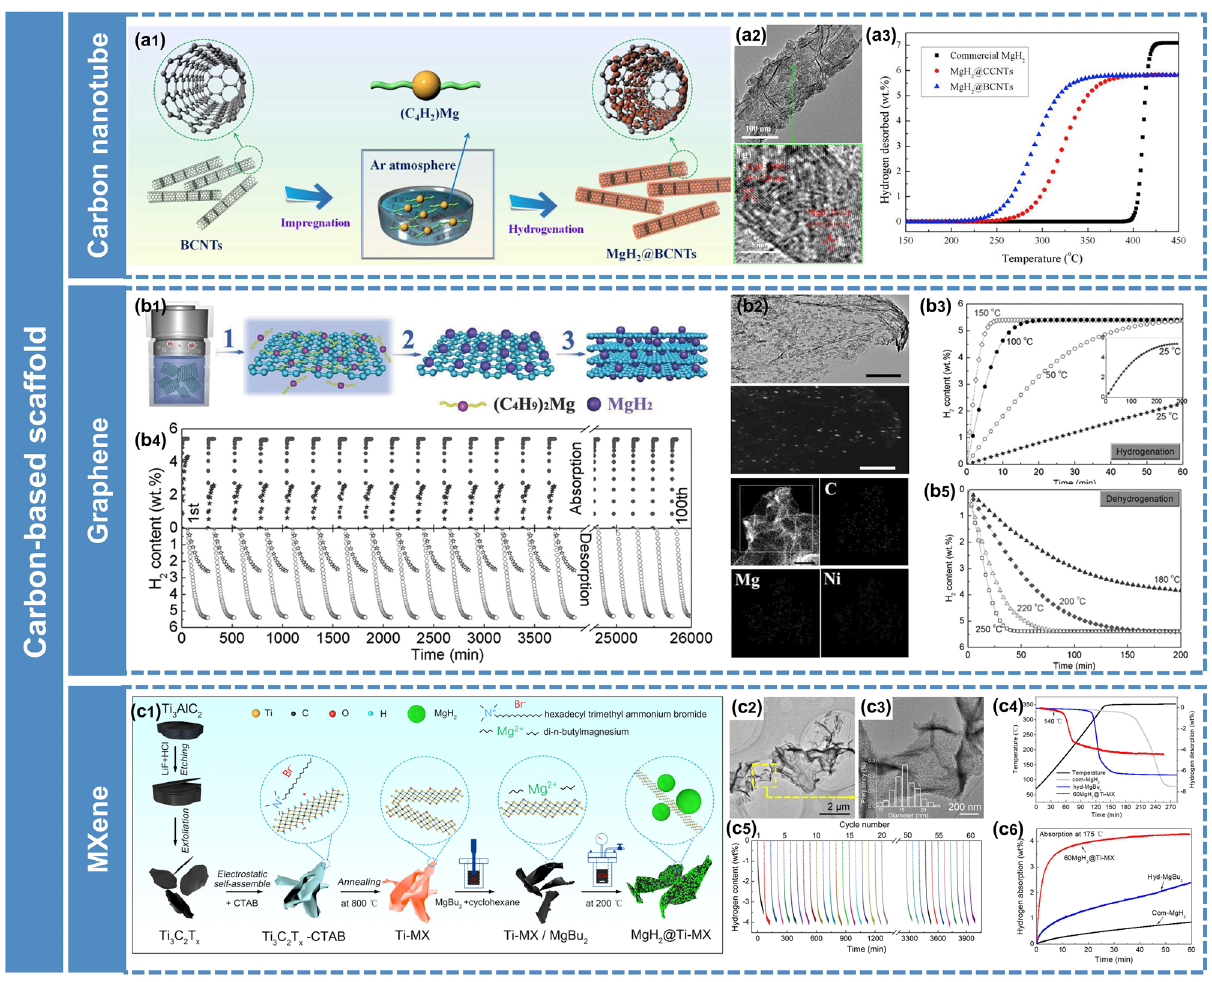
Fig. 9 Synthesis of nanostructured Mg-based composites through the nano-confinement method. a1 Schematic illustration of the self-assembly of MgH 2 NPs on the BCNTs. a2 Representative TEM and HRTEM images of MgH 2 @BCNTs. a3 TPD curves of different samples. Reproduced with permission from Ref. [115]. Copyright 2019 Elsevier. b1 Schematic illustration of the self-assembly of MgH 2 NPs on GR. b2 TEM, STEM images of Ni-MHGH-75, and corresponding elemental mapping images. b3 Hydrogenation and b5 dehydrogenation of Ni-MHGH-75 at various temperatures. b4 Reversible H 2 absorption and desorption of Ni-MHGH-75 (circles) and MHGH-75 (stars) at 200 °C. Reproduced with permis- sion from Ref. [116]. Copyright 2015 John Wiley and Sons; c1 Schematic illustration of the fabrication of MgH 2 @Ti-MX. c2, c3 TEM images of the 60MgH 2 @Ti-MX. c4 TPD curves of different samples. c5 Cycling dehydrogenation curves of 60MgH 2 @Ti-MX at 200 °C. c6 Isothermal hydrogenation curves of different samples. Reproduced with permission from Ref. [117]. Copyright 2021 American Chemical